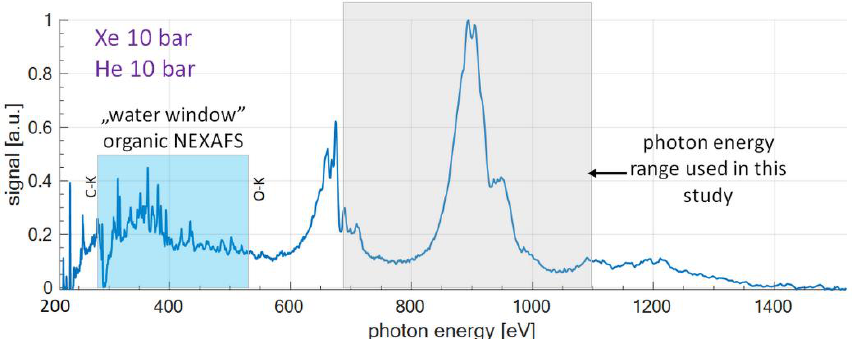
Figure 2. SXR reference spectrum in the photon energy range of 200–1500 eV, obtained for Xe and He gas backing pressures of 10 bar. The Blue region indicated well known “water window” spectral range that can be used for NEXAFS of organic materials (C and O-K edges are indicated). Gray region indicates 680–1100 eV region used for L-edge NEXAFS of transition metals, reported in this study.